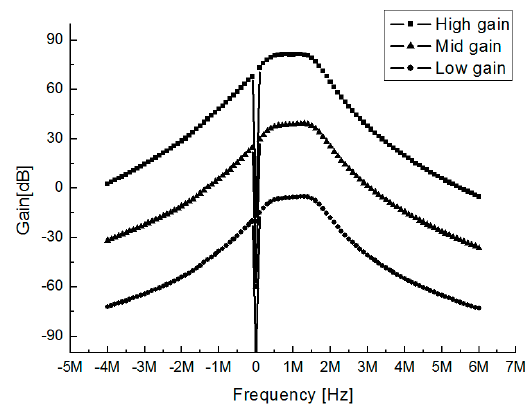
Figure 25. The measured gain and bandwidth of BBA. Sensors 2019 , 19 , x FOR PEER REVIEW